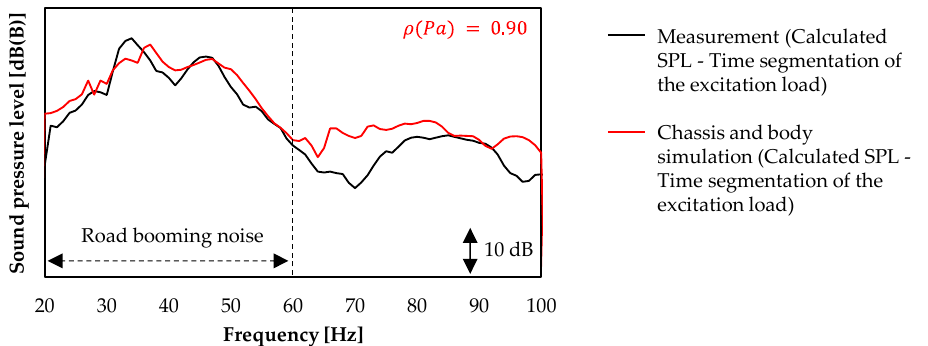
Figure 6. Comparison of the calculated sound pressure level of a vehicle for driving on a rough road (test track, non-uniform road profile at 40 km/h) based on measurements and based on a combination of a chassis and body simulation model (complete vehicle simulation model).